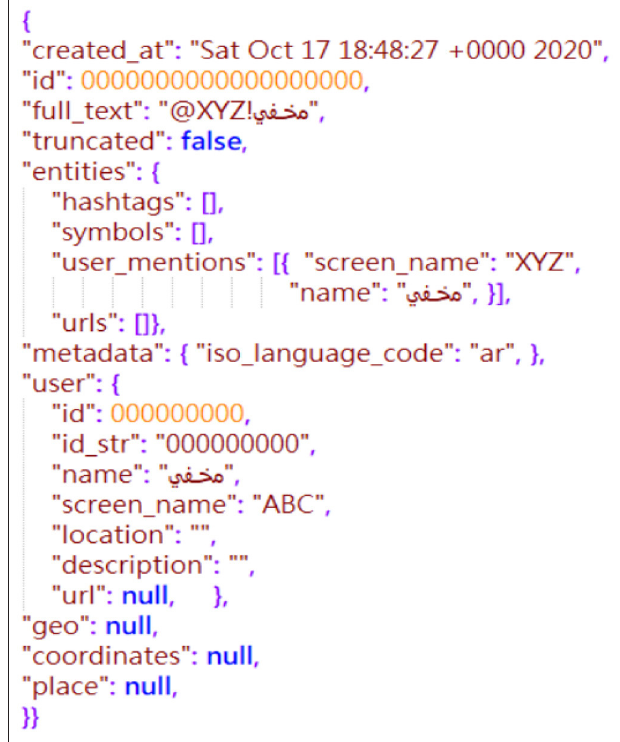
Figure 2 | Example of a tweet object (JSON format).